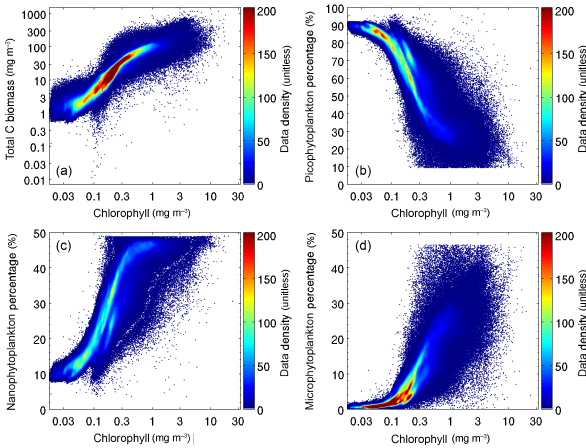
Figure 7. Smoothed bivariate histograms of chlorophyll concen- tration and (a) total phytoplankton C biomass, (b) picoplankton, (c) nanoplankton and (d) microplankton fractional contributions to the total algal C biomass. The histograms were computed from the global mission composite of standard mapped SeaWiFS obser- vations (September 1997–December 2010). The colors indicate the number of pixels that fall into each bivariate bin. The counts are shown in linear space, whereas the bins themselves are in logarith- mic space. Data from continental shelf regions (<200m depth) are